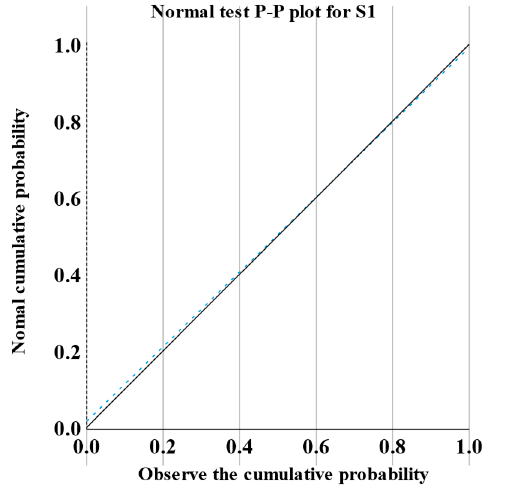
Figure 8. Histogram of the sensor S1 normality test.